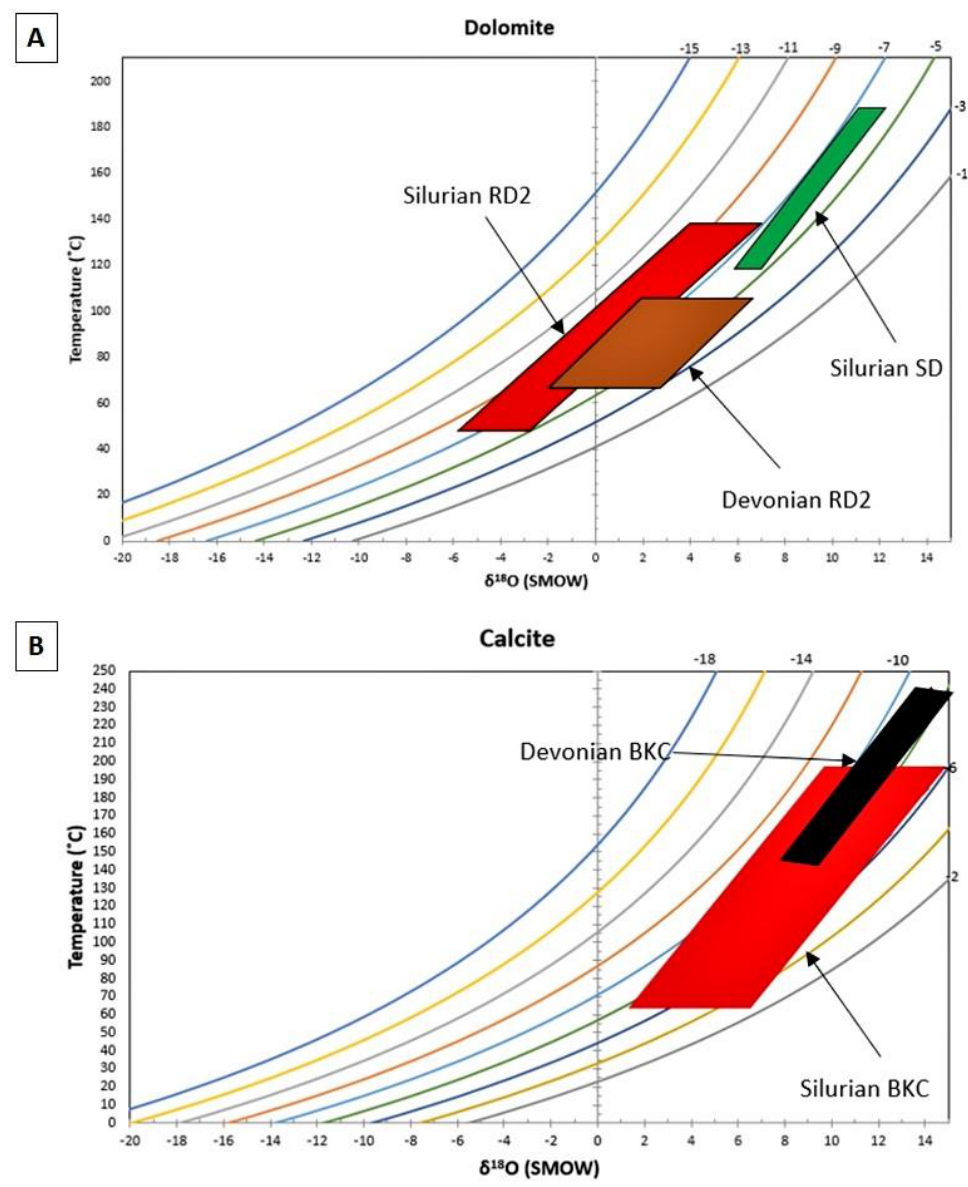
Figure 21. ( A ) Oxygen isotope values of dolomite from Silurian and Devonian formations plotted on the temperature-dependent, dolomite-water oxygen fractionation curve [82]. ( B ) Oxygen isotope values of calcite cement from Silurian and Devonian formations plotted on the temperature-dependent, calcite-water oxygen fractionation curve